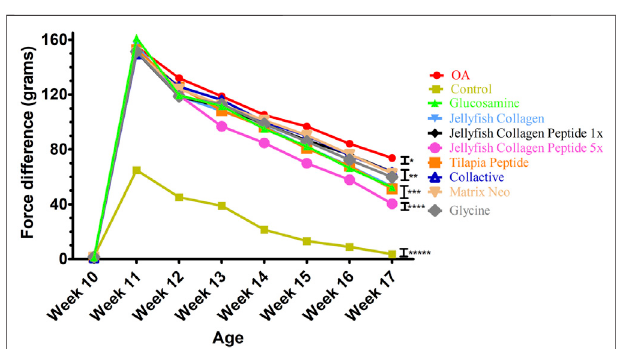
FIGURE 7 | Effects of Collagen, Collagen peptide, Glycine, and glucosamine sulfate treatment on the weight-bearing of the hind limbs in ACLT+MMx surgery-induced OA male